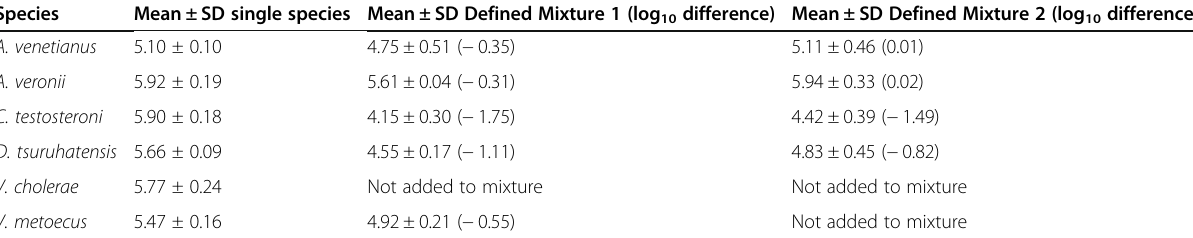
Table 1 Normalized cell-equivalent log 10 bacterial load values for monoassociation and mixture experiments